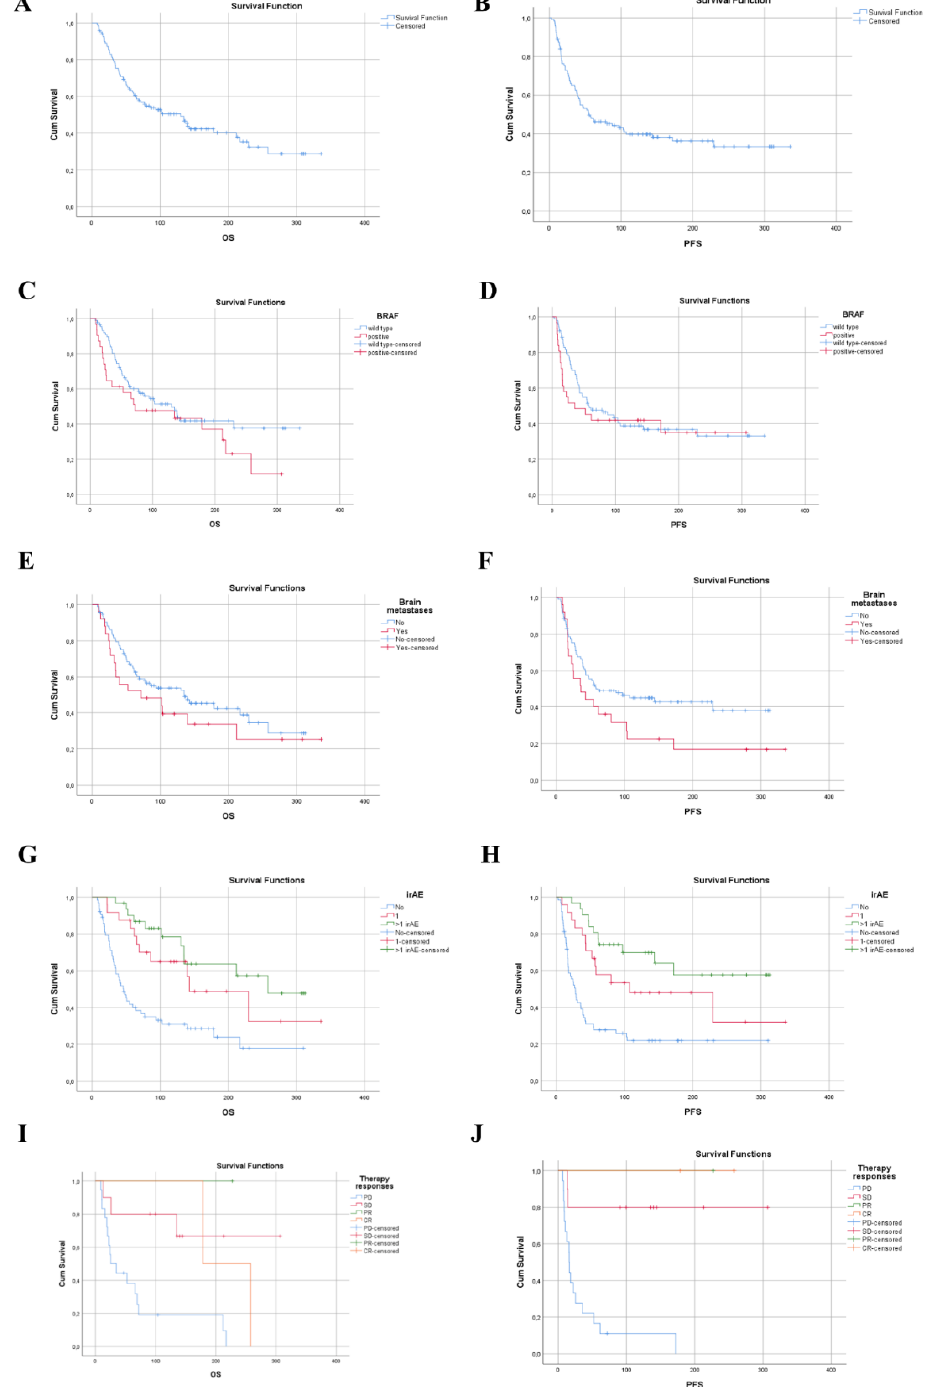
Figure 1. Kaplan–Meier survival estimates the survival. ( A ) OS in whole population, ( B ) PFS for whole population, ( C ) OS according to BRAF status, HR for death for patients with BRAF mutation was 1.96 (95% CI 1.02–3.77, p = 0.004), ( D ) PFS according to BRAF status, HR for progression for patients with BRAF mutation was 2.68 (95% CI 1.26–5.72, p = 0.011), ( E ) OS according to presence of brain metastases, HR for death 0.84 (95% CI 0.09–7.73, p = 0.880), ( F ) PFS according to presence of brain metastases, HR for progression 1.62 (95% CI 0.18–14.25, p = 0.666), ( G ) OS according to irAE, HR for death 0.3 (95% CI 0.14–0.64, p = 0.02), ( H ) PFS according to irAE, HR for progression 0.26 (95% CI 0.13–0.54, p = 0.000), ( I ) OS according to response of therapy, HR for death 0.14 (95% CI 0.05–0.43, p = 0.001), ( J ) PFS according to response of therapy, HR for progression 2.06 (95% CI 0.24–17.84, p =